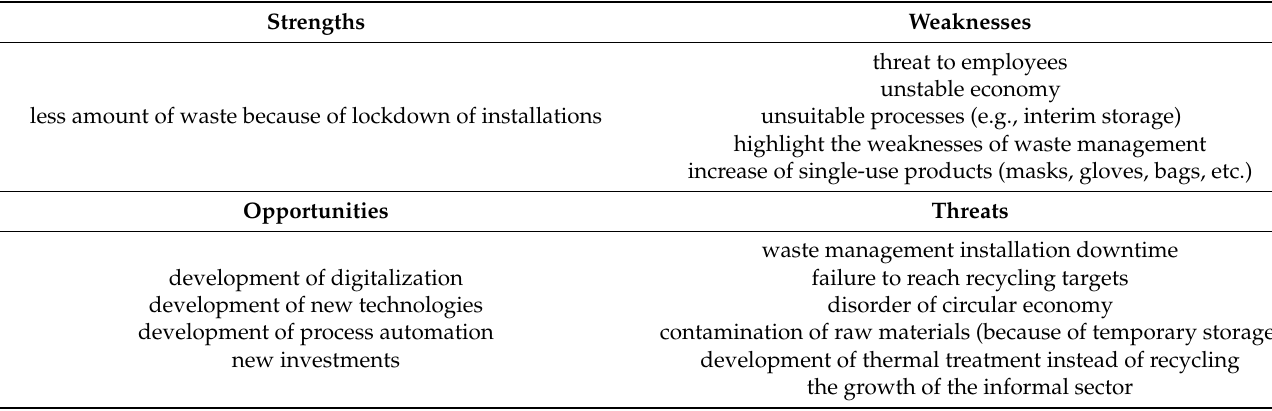
Table 4. SWOT—(Strengths, Weaknesses, Opportunities, and Threats in the circular economy and waste management due to